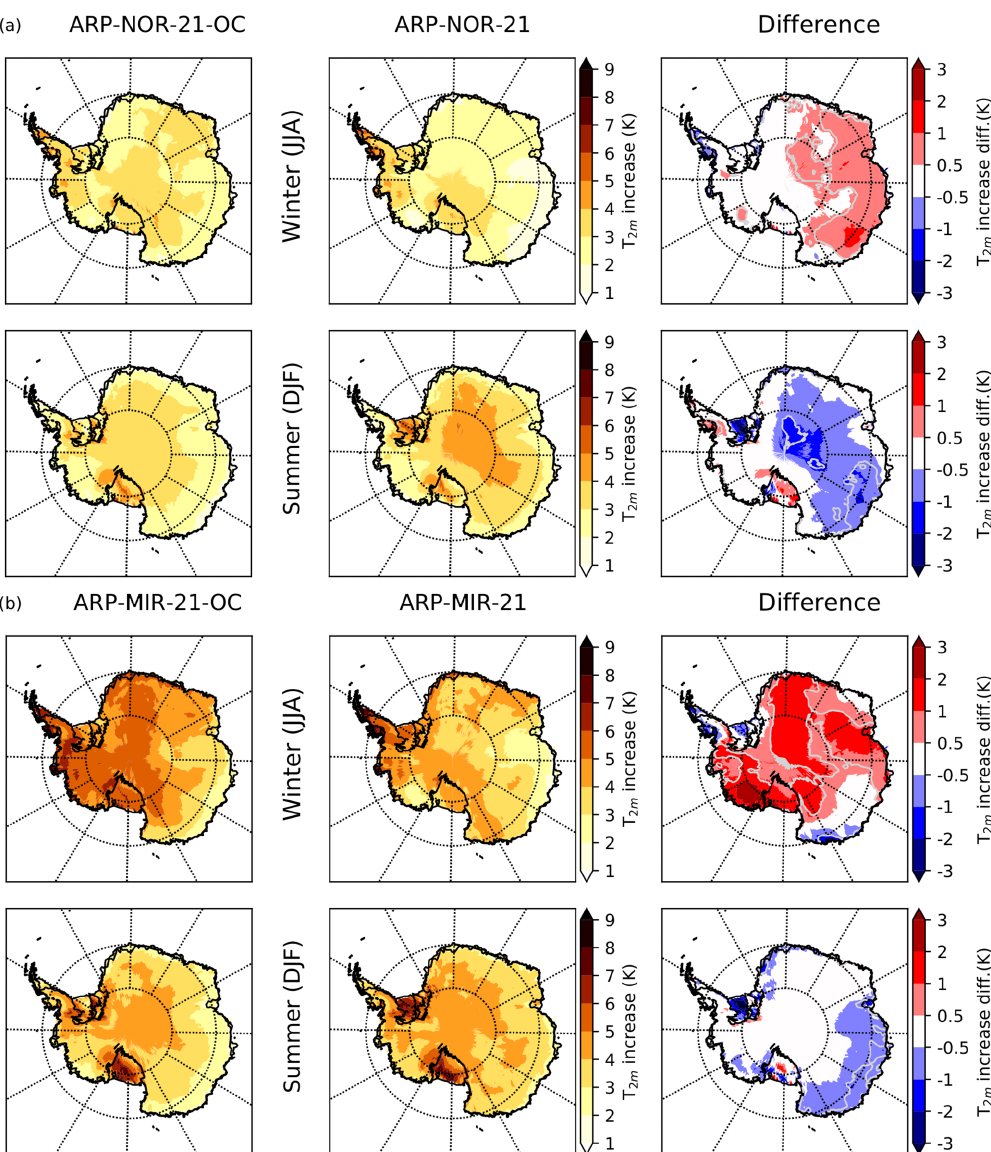
Figure 7. Climate change signal in T 2m for ARPEGE RCP8.5 projections for the late 21st century (2071–2100) with bias-corrected SSCs (left), original SSCs (centre) and the difference (right). Climate change signals for austral winter (summer) are displayed at the upper (lower) part of the figure. Results for projections with SSCs from NorESM1-M are presented in (a) and from MIROC-ESM in (b) . Grey contour lines show where differences in climate change signal are 25% of the climate change signal using non bias-corrected SSCs. Table 6. Mean seasonal T 2m increase (K) for the grounded AIS for the different ARPEGE RCP8.5 projections for the late 21st